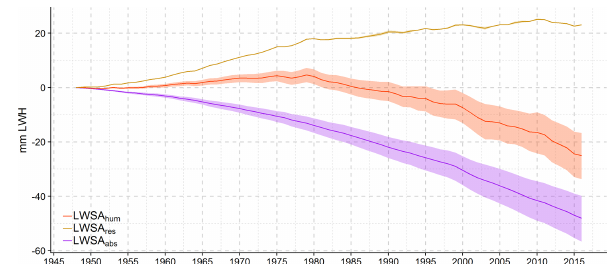
Figure 6. Global mean annual human-driven LWSA and indi- vidual contributions from 1948 to 2016. Human-driven LWSA (LWSA hum ; as in Fig. 5c) is disaggregated into anomaly due to reservoir operation (LWSA res ) and water abstraction (LWSA abs ) . Anomalies are relative to the year 1948 and given in millimetres of land water height